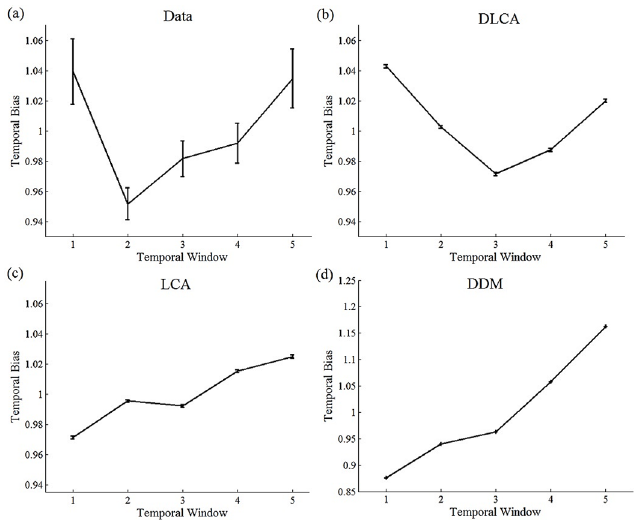
Fig 7. Data and models ’ predictions of temporal weight index (left panel) and regression weights (right panel) in 3-sec trials. A) Observed temporal weights (N = 33; error bars denote 1 within-participant S. E.M; [39]); B) Predictions of the Dynamic LCA (DLCA); C) Predictions of the LCA; D) Predictions of the DDM with cf. Fig